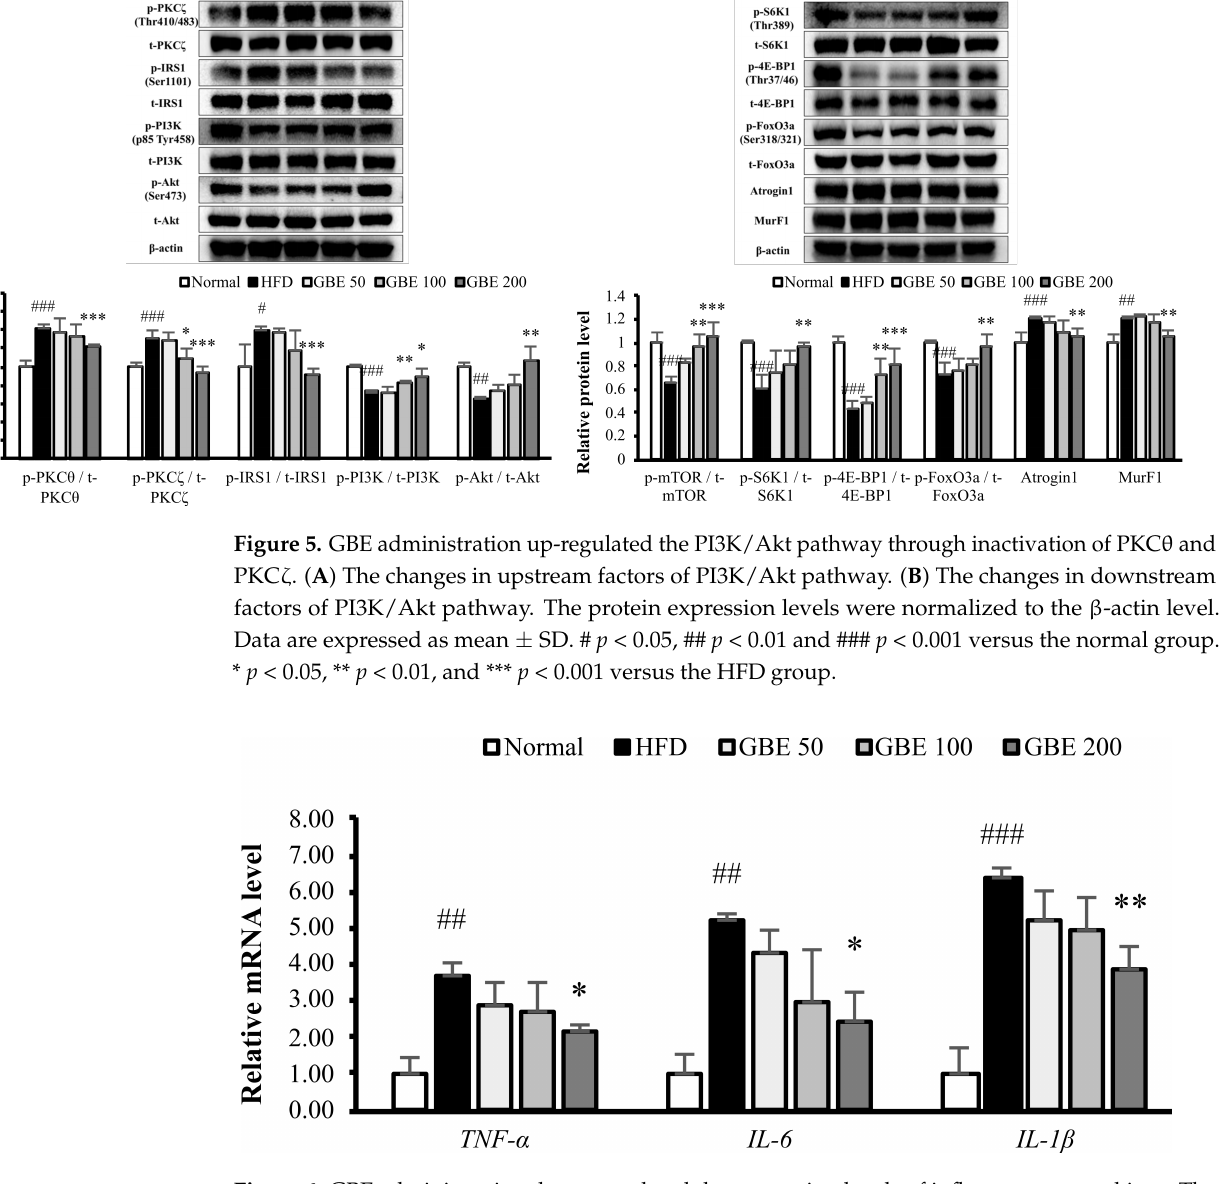
Figure 6. GBE administration down-regulated the expression levels of inflammatory cytokines. The mRNA expression levels were normalized to the gapdh level. Data are expressed as mean ± SD. ## p < 0.01, and ### p < 0.001 versus the normal group. * p < 0.05, ** p < 0.01, versus the HFD